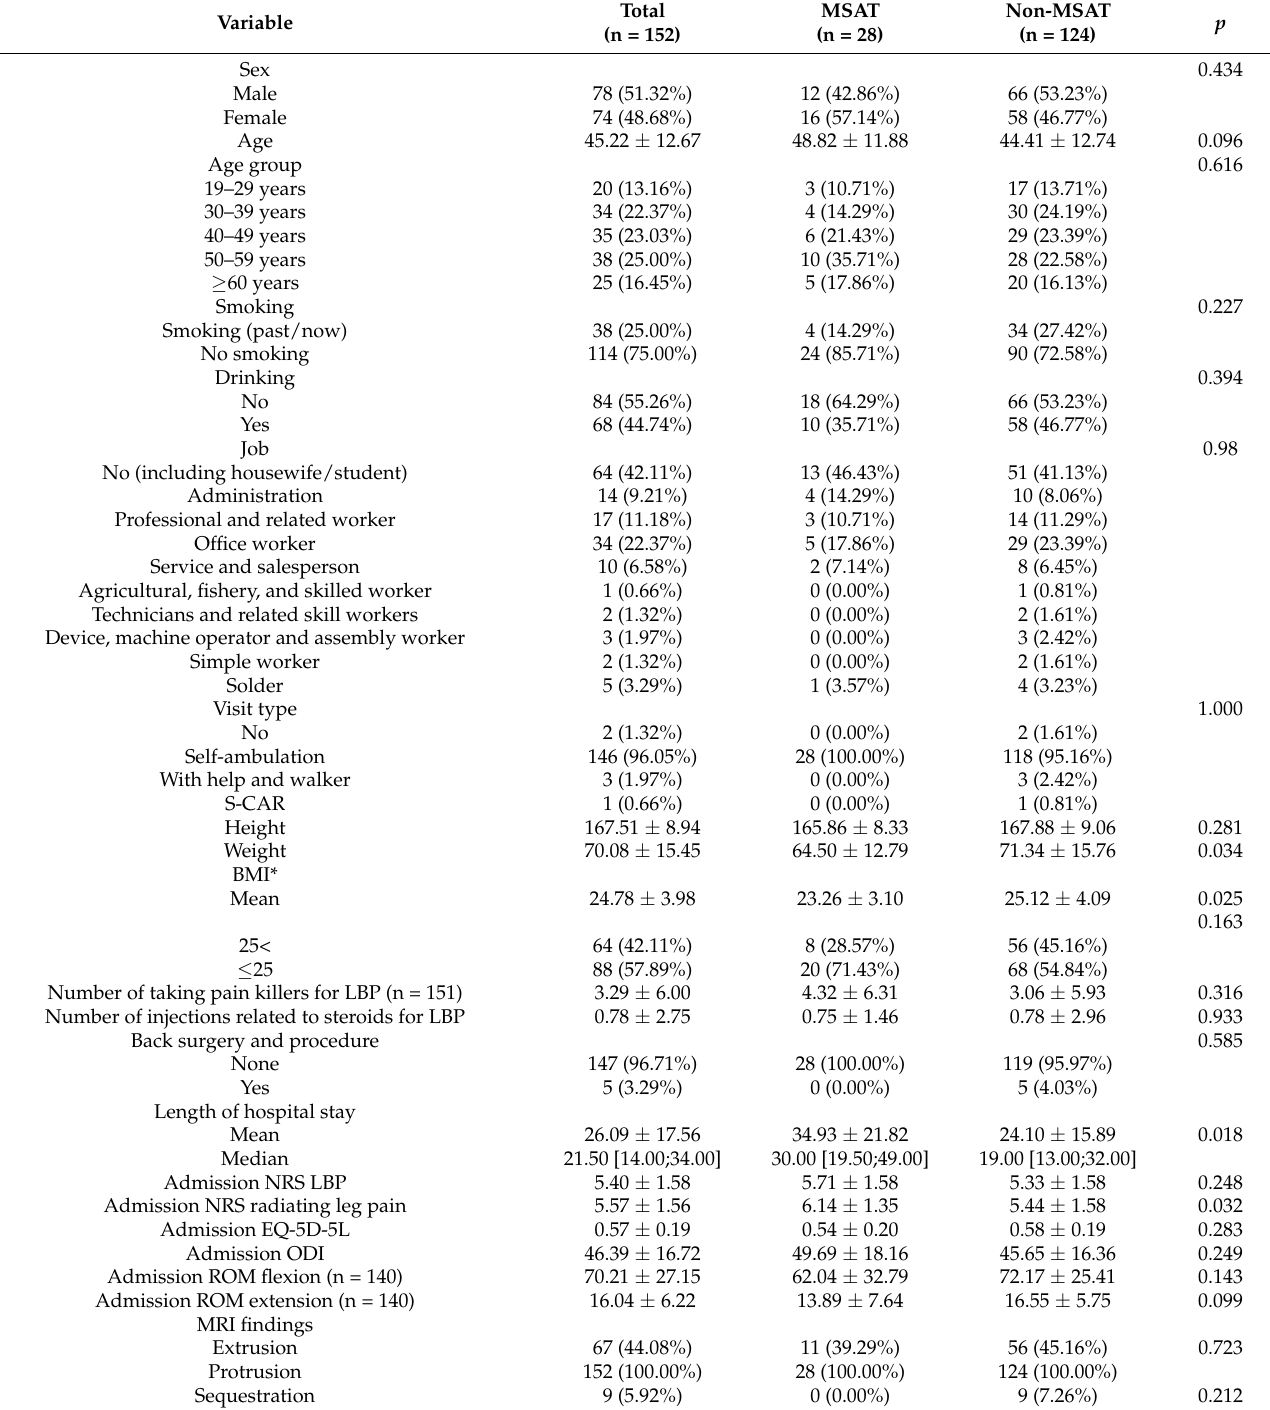
Table 1. Basic characteristics of the study